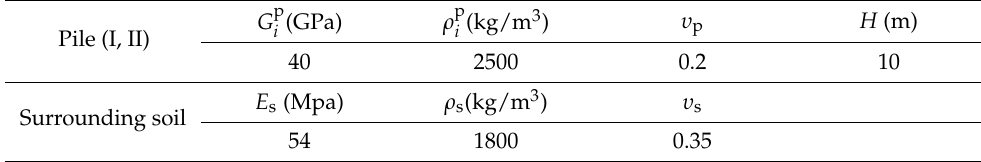
Table 1. The parameters of the pile-soil system in this